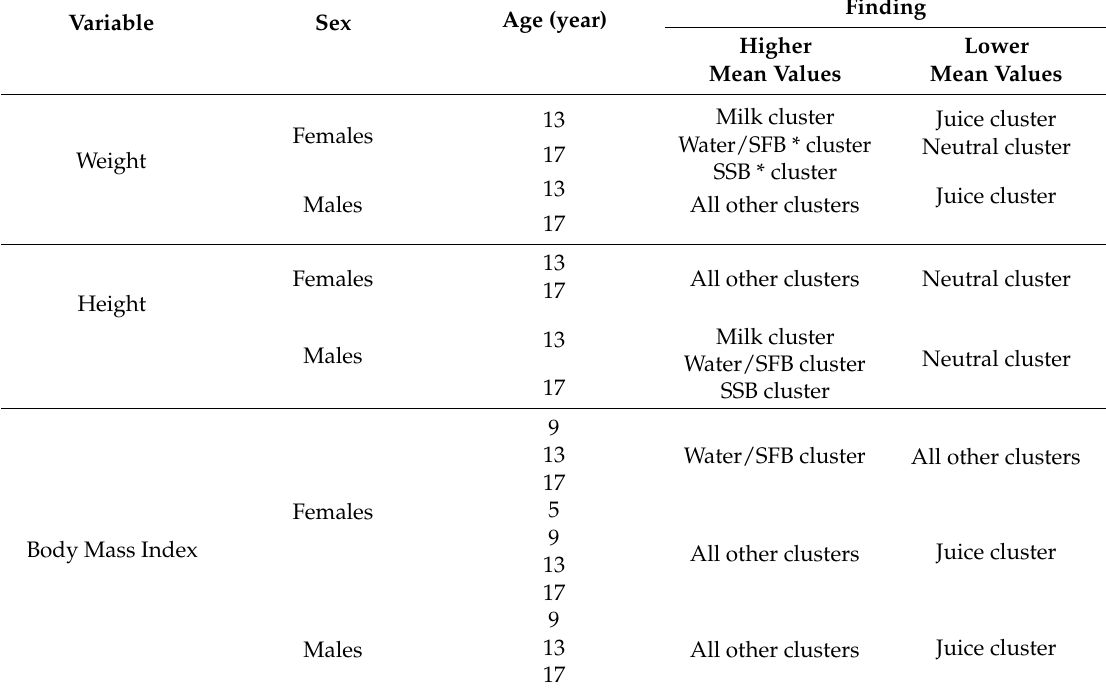
Table 2. Summary of sex and age-specific findings pertaining to mean anthropometric differences